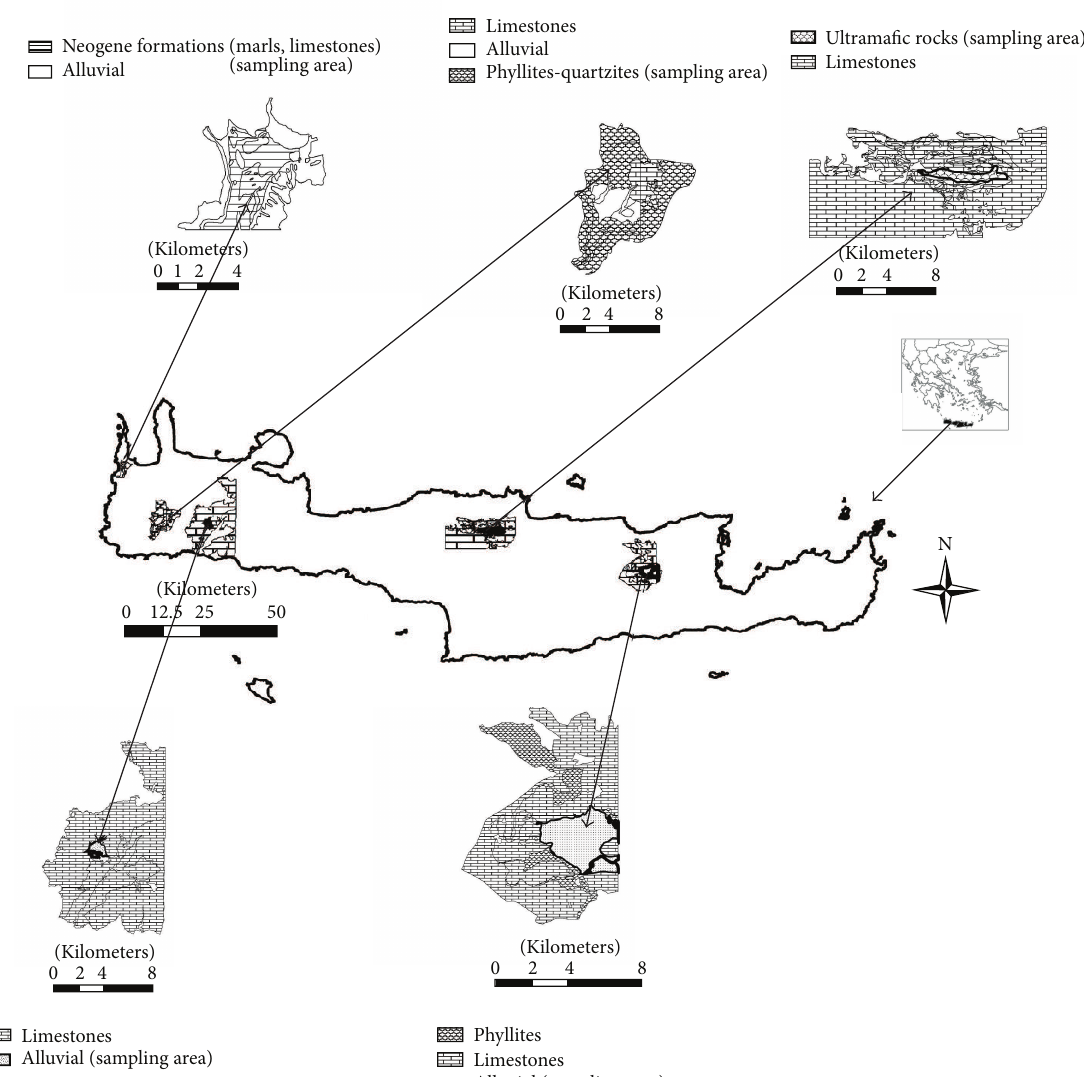
Figure 1: Geological outline in the sampling